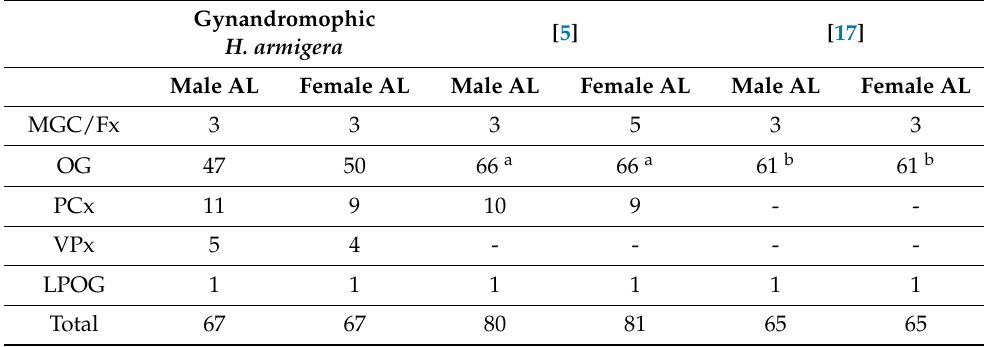
Table 1. Categories and numbers of glomeruli in H. armigera , identified from the present and previous studies. MGC: macroglomerular complex; OG: ordinary glomeruli; PCx: posterior complex; VPx: ventroposterior complex; LPOG: labial pit organ